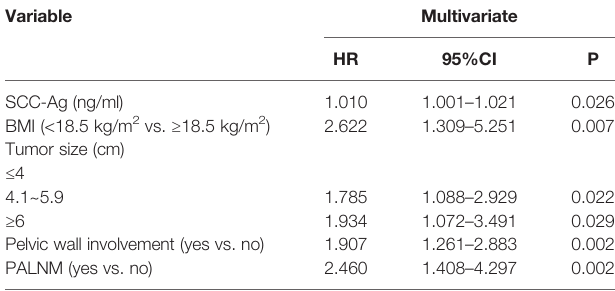
TABLE 3 | Multivariate analysis for overall survival.